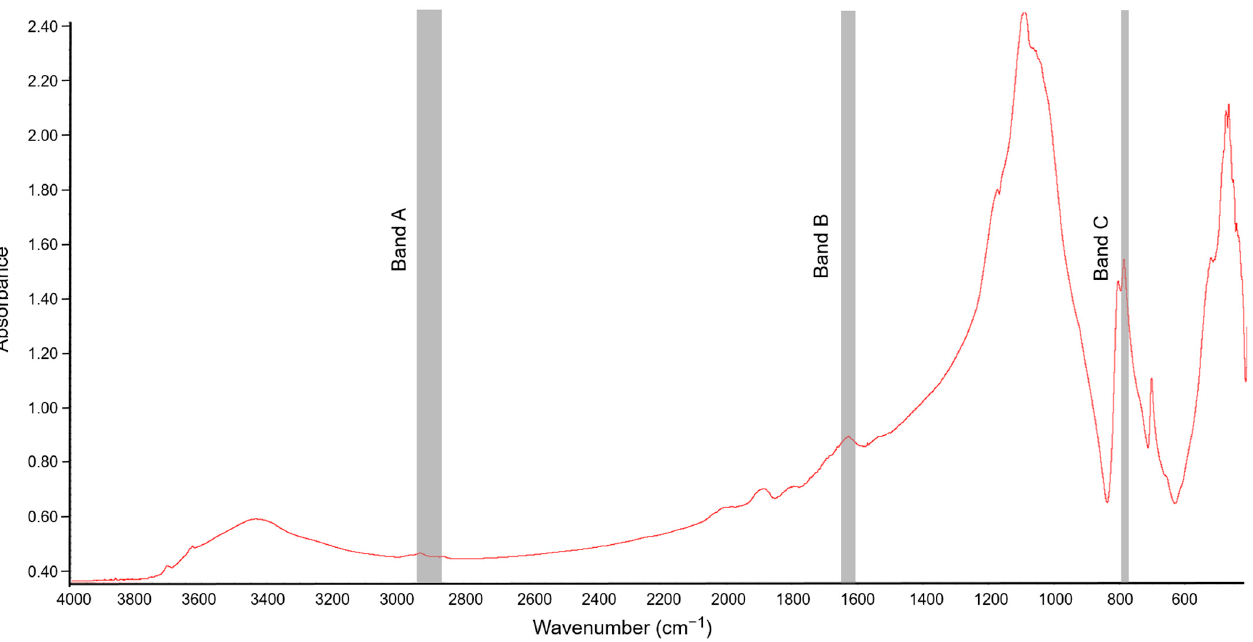
Figure 1. Fourier-transform infrared (FT-IR) spectrum of soil not exposed to tetrabutylphosphonium bromide [TBP][Br]; Band A, Band B, and Band C associated with absorbance of C–H bonds, hydrophilic components, and quartz, respectively.